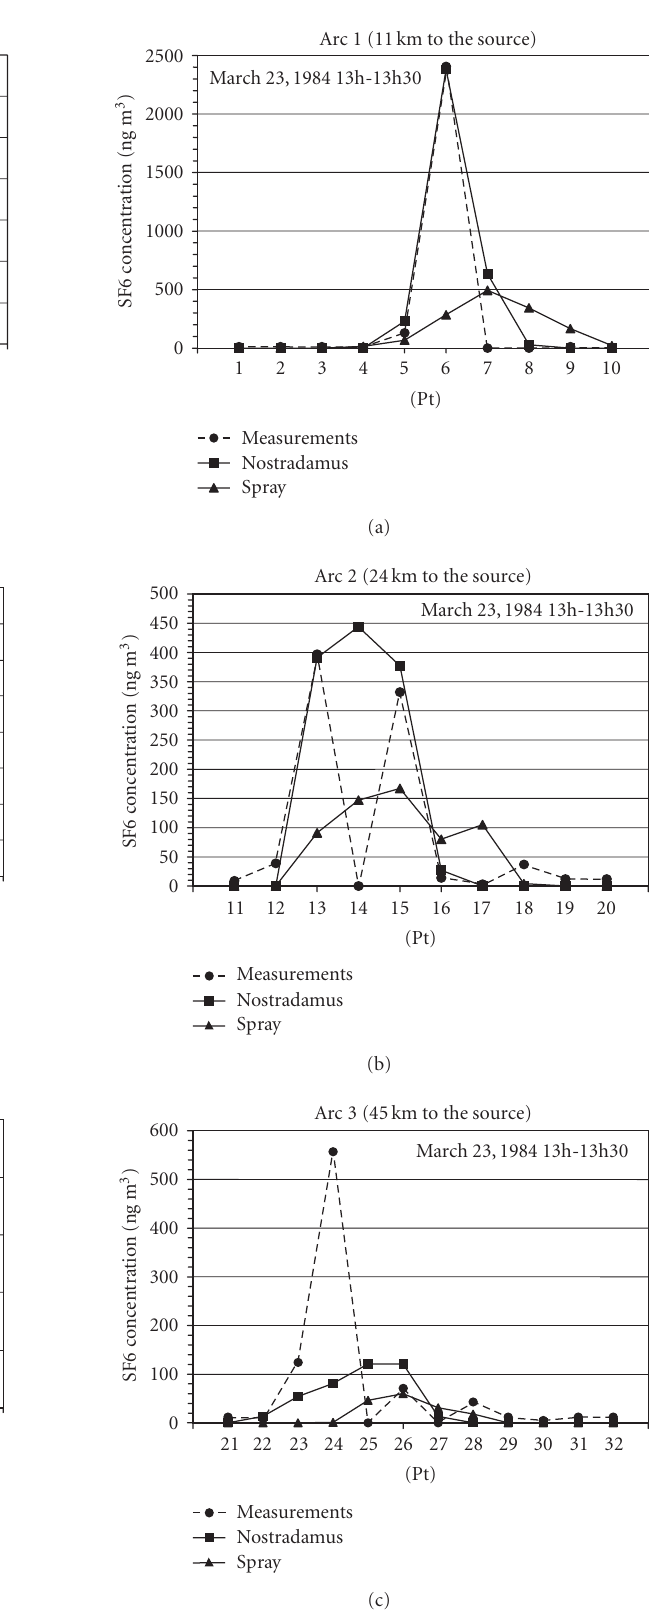
Figure 4: Comparison of SF6 concentration during experiment 2 on three arcs of monitoring points between measurements (at 1 meter above ground level) and NOSTRADAMUS and SPRAY cal- culations (at 10 meters above ground